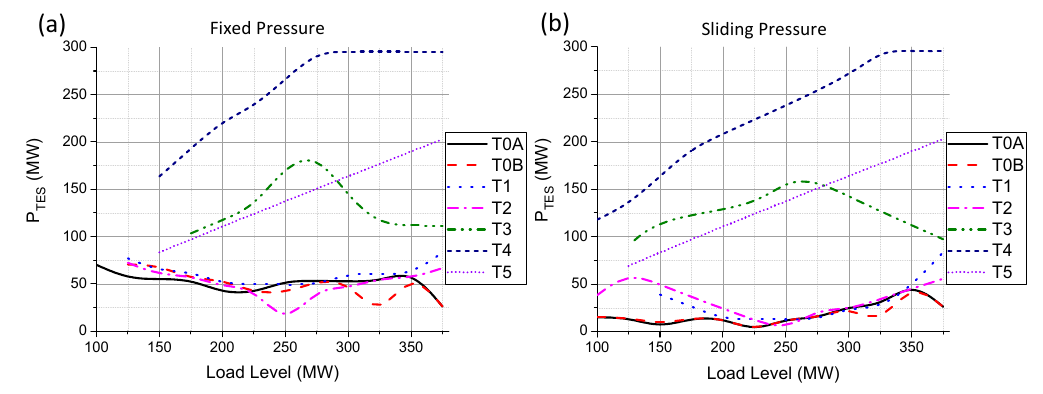
Figure 10. TES charging power ( P TES ) in FP ( a ) and SP ( b ) operating mode.